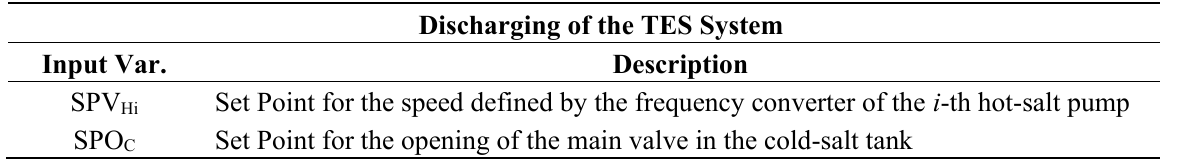
Table 6. TES discharging input variables.